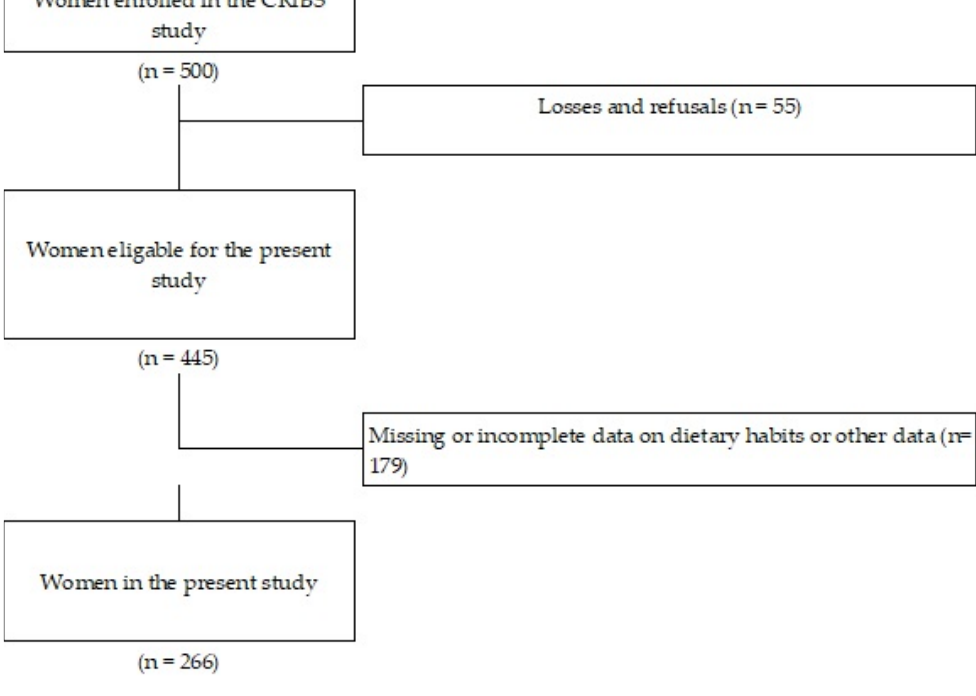
Figure 2. Study flow chart.